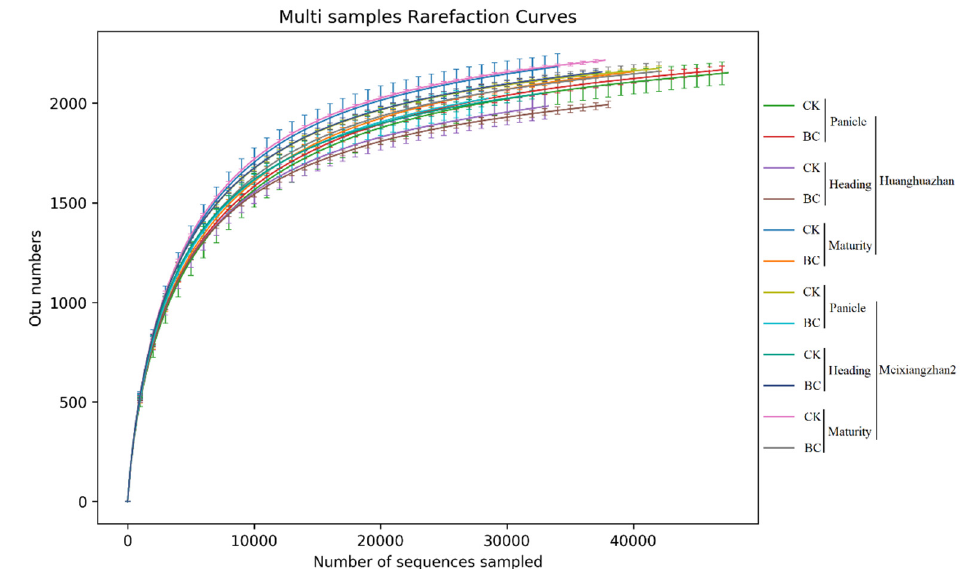
Figure 1. Rarefaction analyses of multi samples. Table 4. Diversity and abundance indices of species of samples.